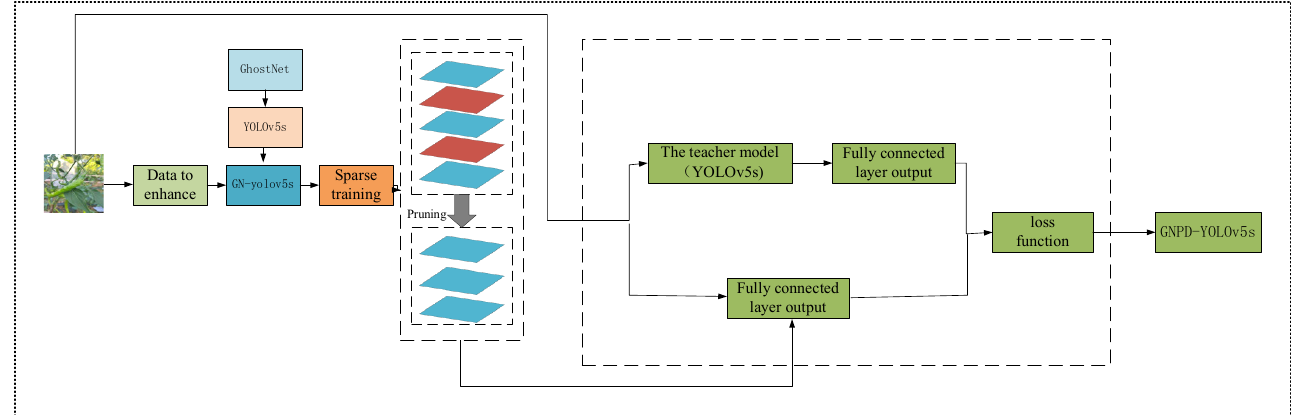
Figure 2. GNPD - YOLOv5 model. Figure 2. GNPD-YOLOv5